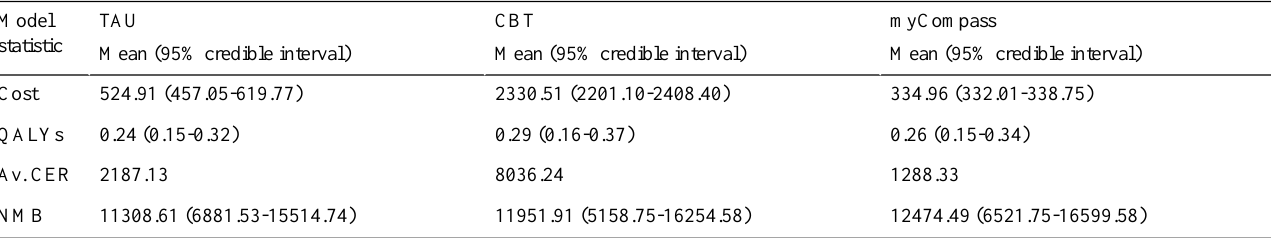
Table 3. Results of PSA, showing differences in costs, health benefits gained, and net monetary